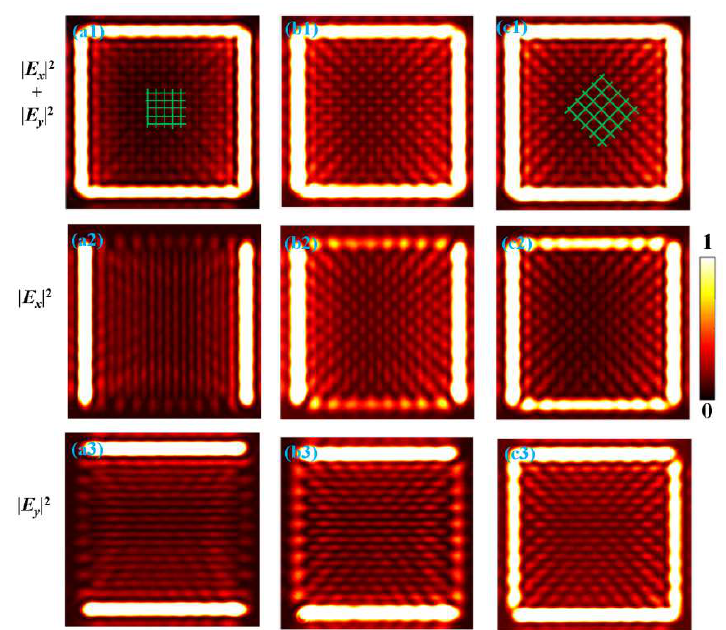
Figure 5. ( a – c ) Experimentally obtained patterns of the square slit samples with w = 100, 150, 200 nm, respectively. ( a1 – c1 ) are the patterns of the total intensities intensities of the x-polarized patterns (cid:12) (cid:12) 2 (cid:12) (cid:12) . The square-like pattern and diamond-like pattern are indicated by the green (cid:12) E y ( x , y ) (cid:12)